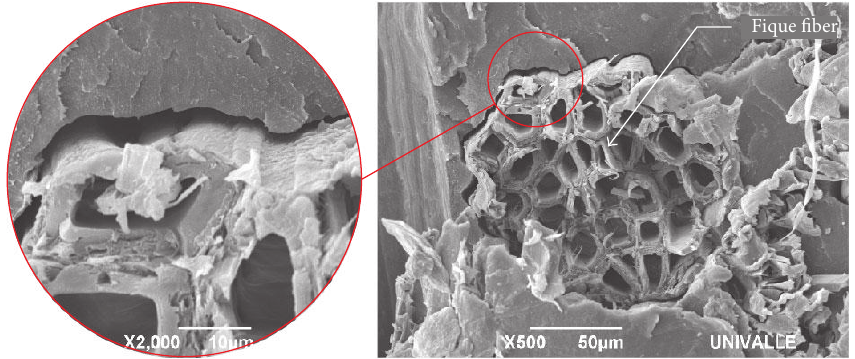
Figure 7: SEM micrograph. Cavities present in the fiber-matrix interface of the LDPE-Al/fique compound.